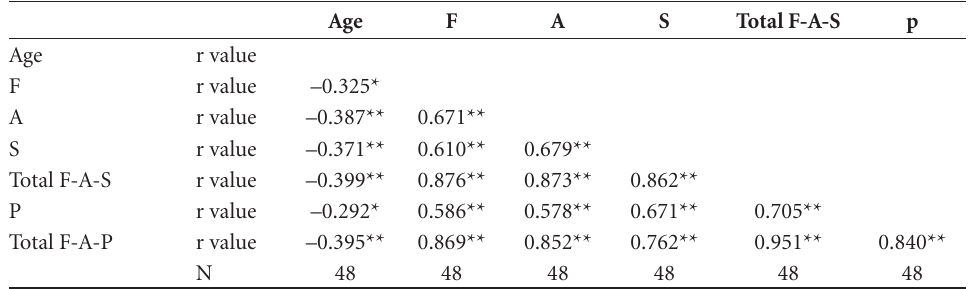
Table 2. Results of Spearman’s correlation test.